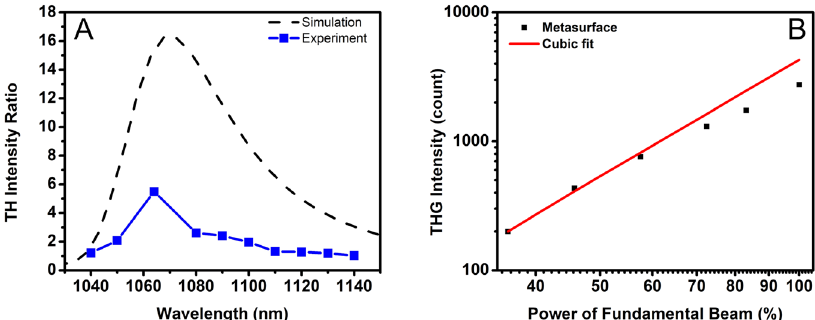
Fig. 4 THG from different fundamental wavelengths and different pump powers. A The simulated and experimental results of the THG enhancement for the metasurface as compared to that of the reference thin fi lm. B The THG power dependence of the metasurface as a function of the power of the fundamental